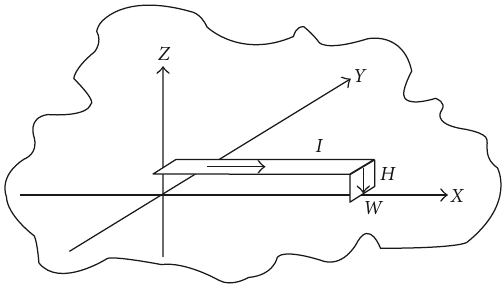
Figure 1: The geometry of a λ/ 4 antenna element above an infinite ground plane. The height of the element above ground is H , its width is W , and its length is λ/